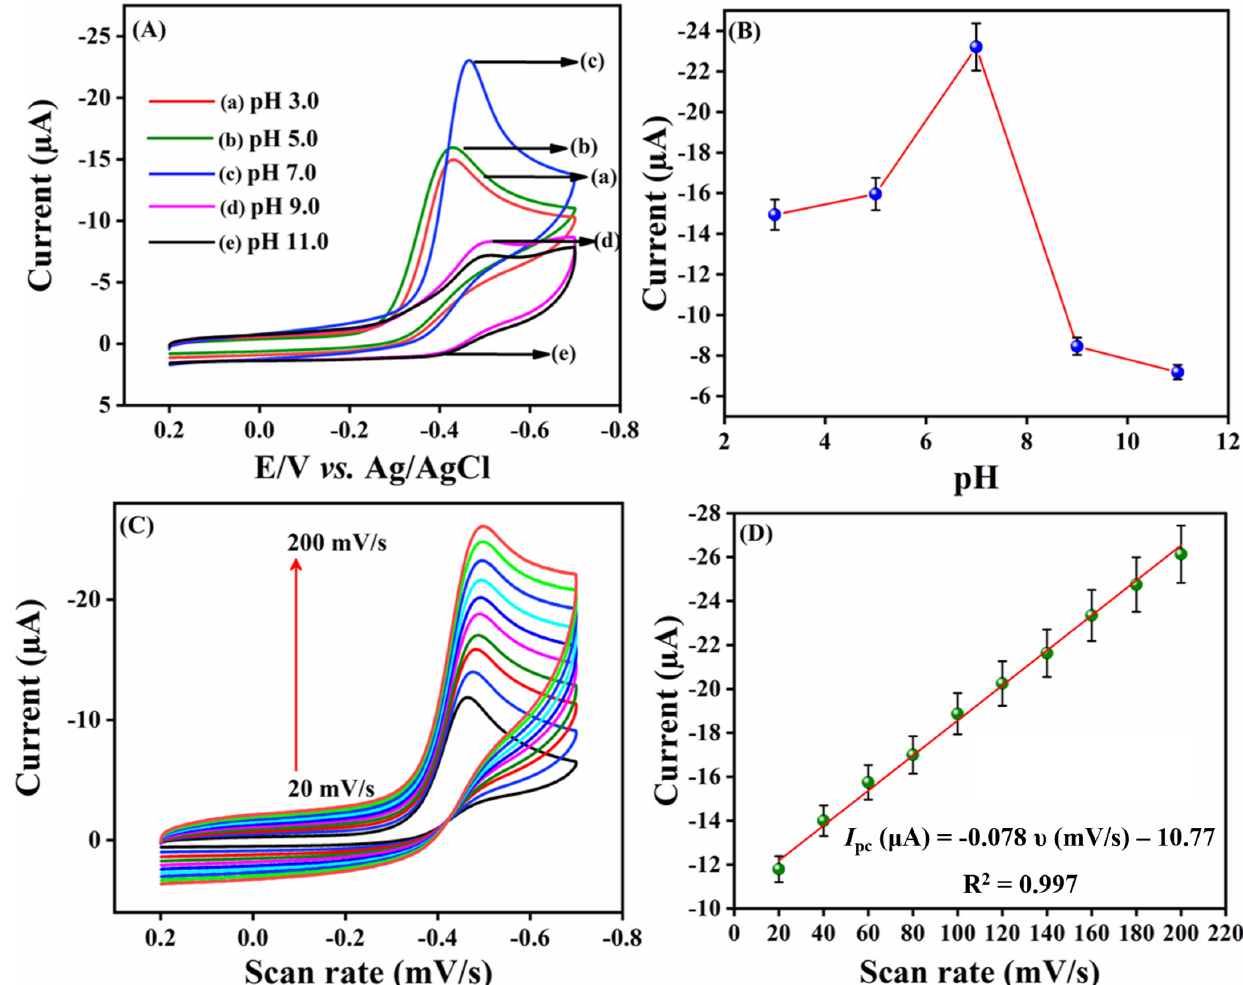
Figure 5. ( A ) CV current response of different pH (pH 3.0 to pH 11.0) in the presence of 200.0 µM FLD at 50 mV/s. ( B ) Linear plot of different pH vs. Current (µA). ( C ) CV profiles of different scan rate in the presence of 200.0 µM FLD in 0.1 M PBS (pH 7.0). ( D ) Calibration plot of different scan rate (mV/s) vs. current (µA). Three replicative measurements ( n = 3) were taken.